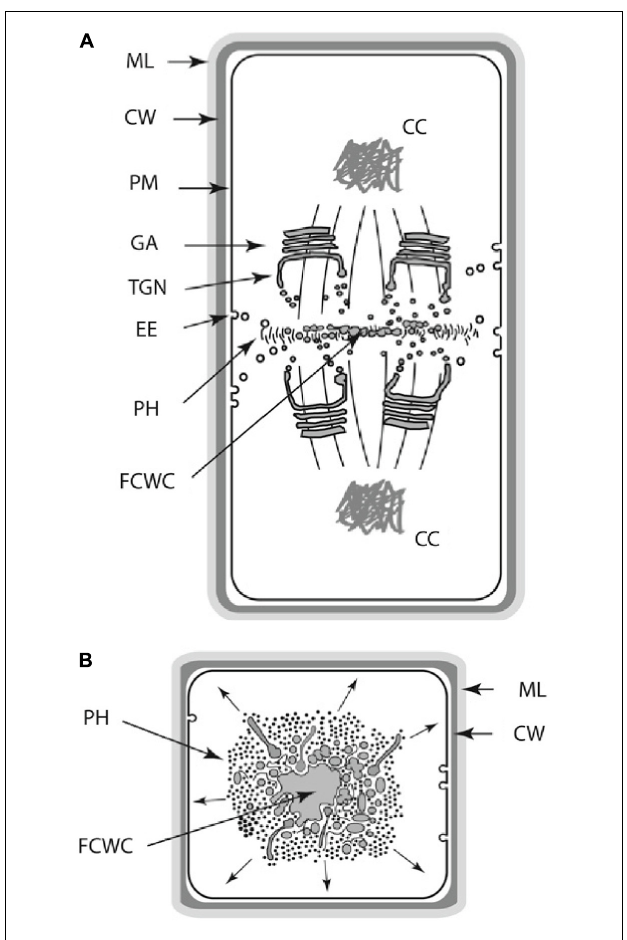
FIGURE 3 | Schematic of the land plant phragmoplast ( A,B : longitudinal and transverse views, respectively). AAC, apical actin cluster; AC, actin cable; AAEP, actin/ABPA endocytoic patches; CC, condensed chromatin; CW, cell wall; EE, endocytotic elements; FCWC, future cell wall components; GA, Golgi apparatus; ML, middle lamella; MT, microtubule; PH, phragmoplast; PM, plasma membrane; SE, post-Golgi sorting endosome; TGN, trans -Golgi network; VC, vesicle cluster.